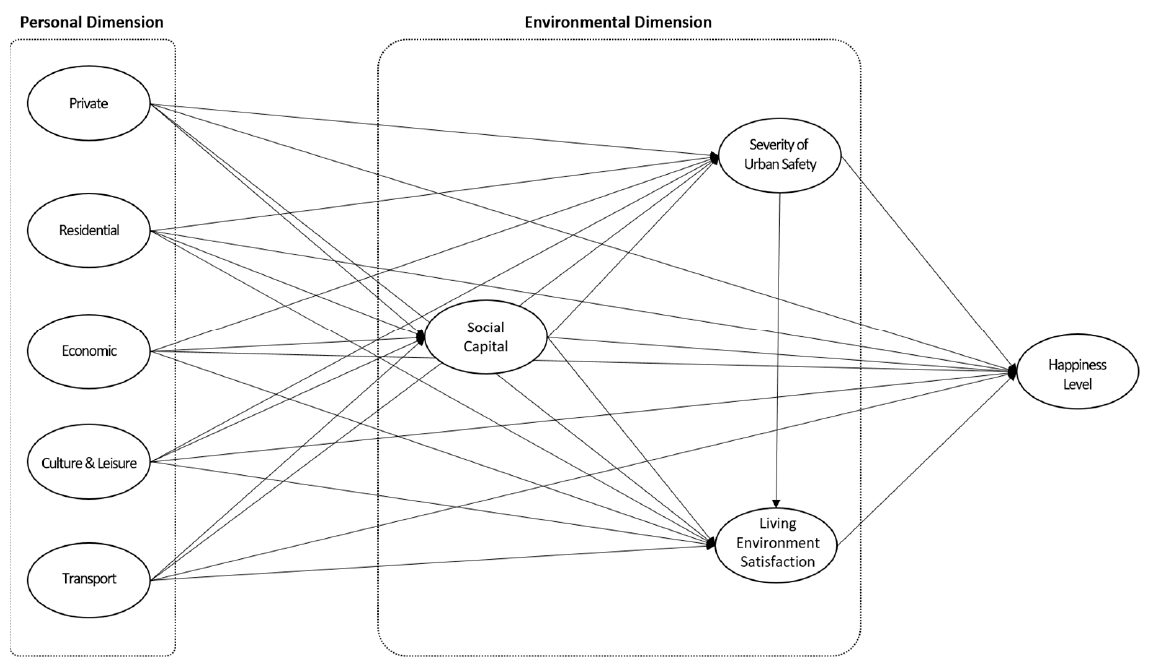
Figure 2. Conceptual research model.